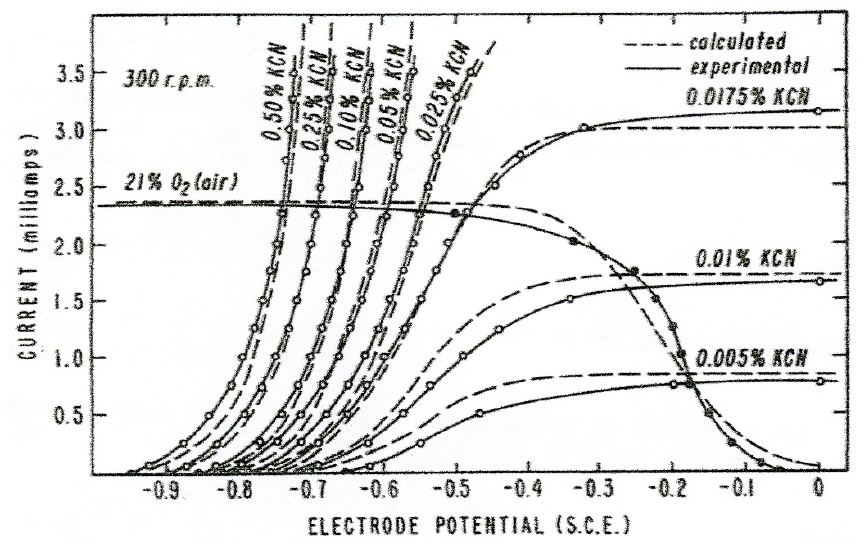
Figure 3. Kudryk and Kellogg [43] electrochemical data for anodic dissolution of Au and cathodic discharge of oxygen. Dashed curves calculated using mixed-kinetics model.